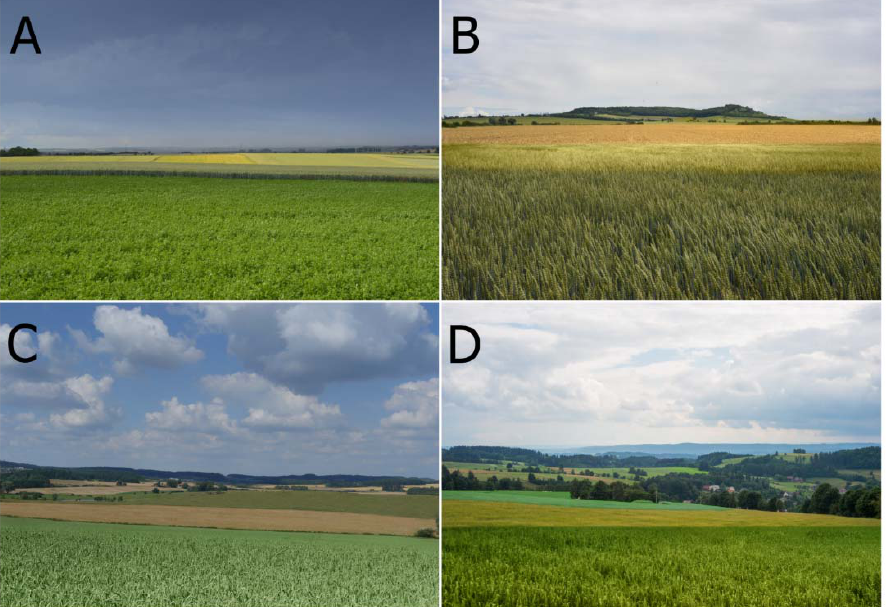
Figure 1. Four different types of agricultural landscapes ( A – D ) were used in our research. ( A )—the lowest baseline landscape heterogeneity, determined by flat terrain and almost no three-dimensional landscape structures; ( B )—second lowest baseline landscape heterogeneity, determined by flat terrain with a forested horizon; ( C )—higher baseline landscape heterogeneity, determined by a slightly rolling morphology, a forested horizon and medium-dense vegetation structures; ( D )—highest baseline landscape heterogeneity, determined by a distinctive morphology and dense vegetation structures.